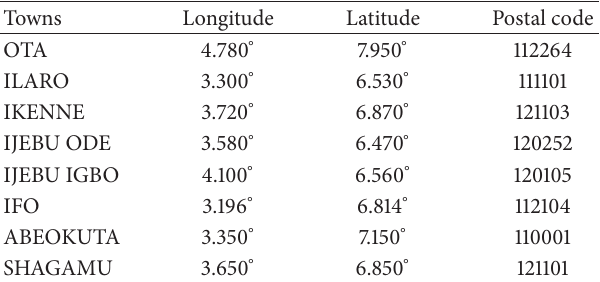
Table 8: Inlet temperature and outlet temperature of water in the SWHS.